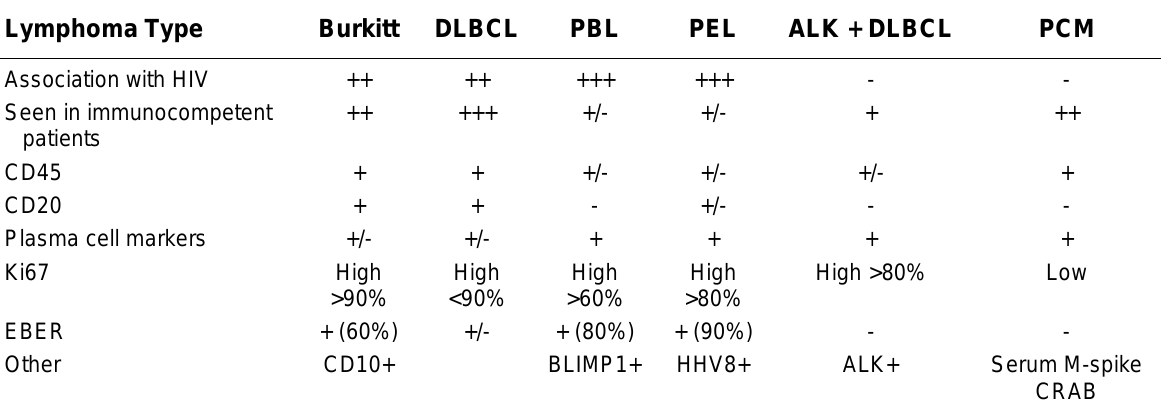
Differential Pathological Diagnosis of